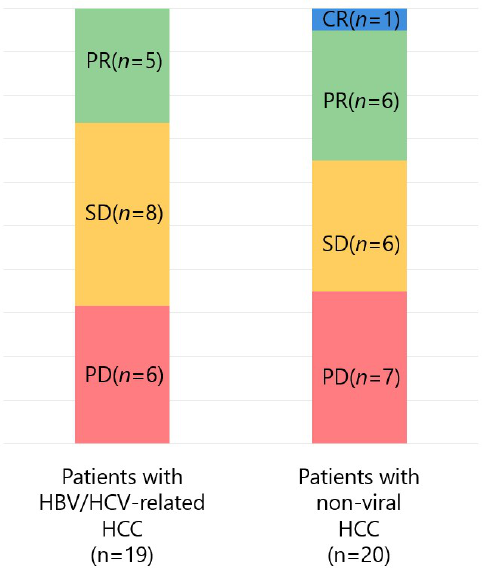
Figure 3. Response to atezolizumab + bevacizumab combination therapy in patients with hepato- cellular carcinoma (HCC) caused by hepatitis virus infection and those with non-viral HCC (CR, complete response; PR, partial response; SD, stable disease; PD, progressive disease; HBV, hepatitis B virus; HCV, hepatitis C virus).